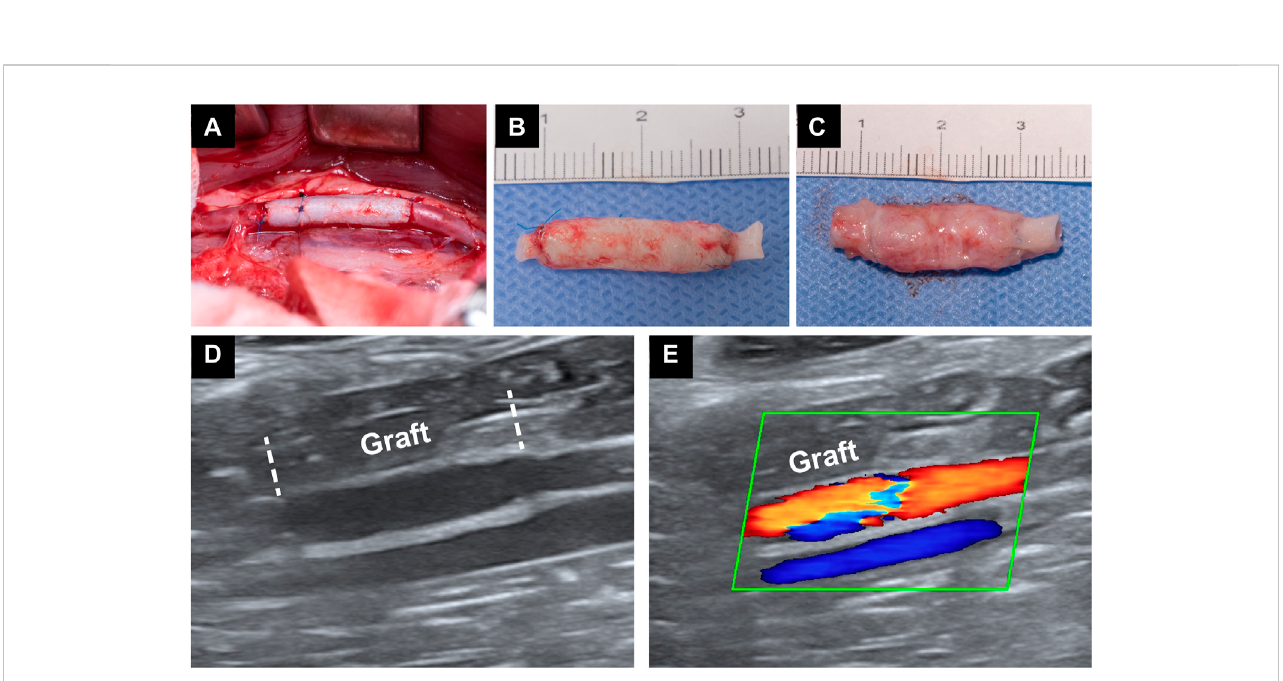
FIGURE 8 Rabbit abdominal aorta interposition model. (A) is a photo of the implanted graft immediately after the surgery. (B) is a photo of a graft which was implanted for 1 week. (C) is a photo of a graft which was implanted for 3 months. (D,E) are the Doppler ultrasound images of an implanted graft.